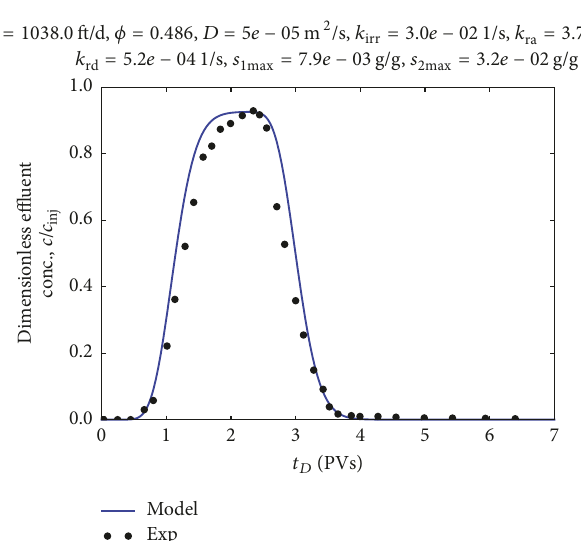
Figure 8: Experimental data [27, 31] and simulated effluent concentration of NPs. The model parameters used to fit the experimental data come from Zhang